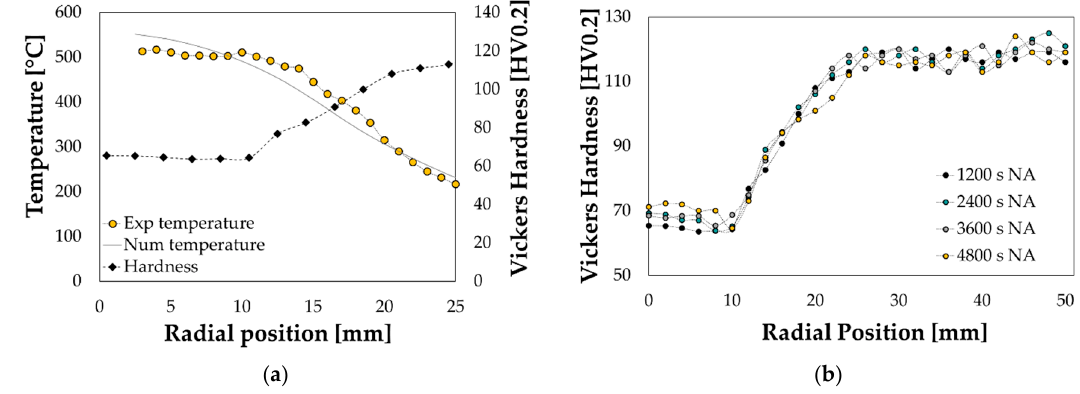
Figure 16. LHT on circular specimen: ( a ) hardness measurement and ( b ) progress of the natural ageing.